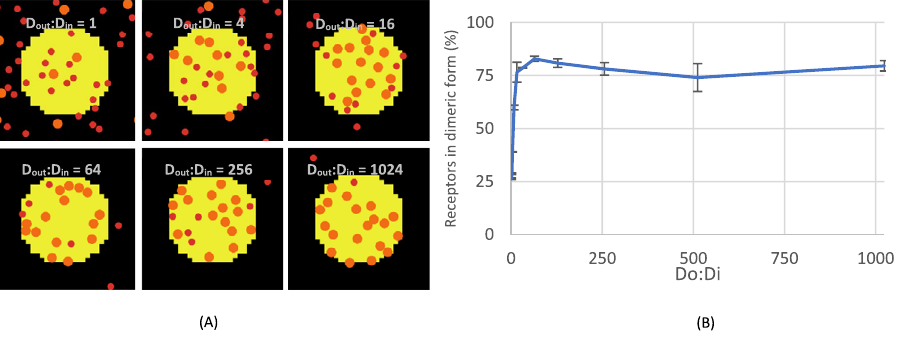
Figure 4. Higher diffusivity ratio enhances receptor confinement and dimerisation. ( A ) Snapshots of simulation of receptors in monomeric (red) or dimeric (orange) forms in the presence of a confined domain (yellow circle). Initially, 47 monomeric receptors were randomly distributed without dimeric form. Simulations were run for ≥ 200,000 steps, with an average of the last 50,000 steps shown. The diffusivity ratio between outside and inside confined domains, D out :D in , was varied from 1 (2 0 ) to 1024 (2 10 ). Snapshots are shown for D out :D in = 1, 4, 16, 64, 256 and 1024. ( B ) Effect of altering the ratio of D out :D in on the number of receptors in dimeric form. Simulations were repeated three times, means ±